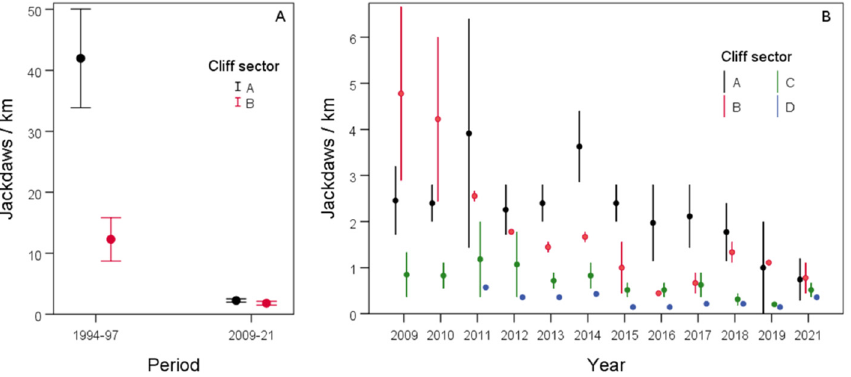
Figure 2. Number of jackdaws (mean ± SE) during the breeding seasons in gypsum cliffs ( A ) in the two study periods (1994–1997 and 2009–2021) in sectors ( A , B ), and ( B ) from 2009 to 2021 in all monitored sectors (see Figure 1 for location of the cliff sectors). Table 1. Models obtained to assess changes in the total number and number of breeding pairs of jackdaws during the breeding season in gypsum cliffs and post hoc tests. ( A ) Comparison between sectors 1 and 2 between 1994–1997 and 2009–2021 and ( B ) among all sectors (1–4) from 2009 to 2021. mean: estimated marginal means; trend: estimated marginal means of trends; SE: standard errors; CI: confidence intervals. Model fits are shown in Figures S1 and S2.